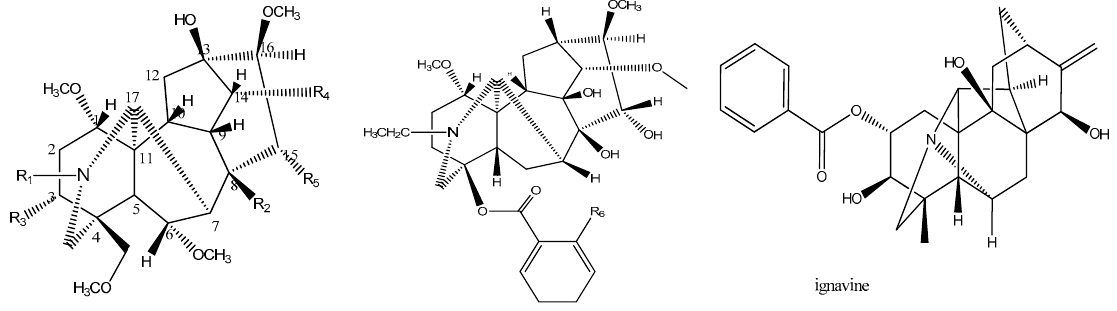
Figure 8. The chemical structures of 15 diterpenoid alkaloids.